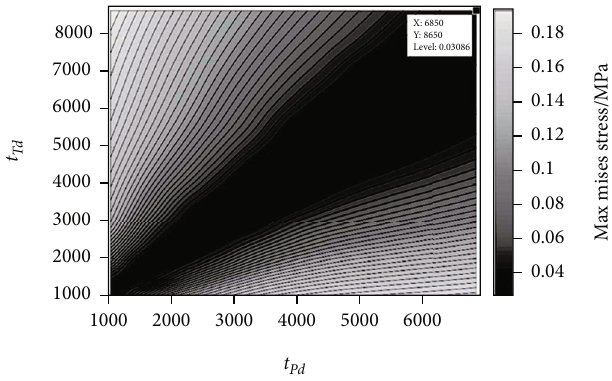
Figure 10: Relationship between design variables and target